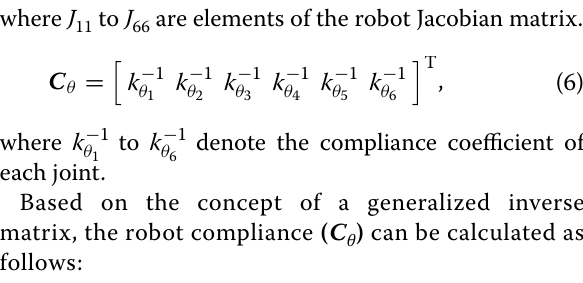
According to the identification method described above, the quantity and distribution of the selected sampling points, which relate to the robot configura- tions, directly affect the accuracy of the identification results [16, 17]. Hence, the fitting result of the joint stiffness in the entire workspace cannot accurately reflect the performance of robots in different subspaces [18]. Therefore, joint stiffness parameters suitable for different workspaces must be determined to increase the stiffness identification accuracy.